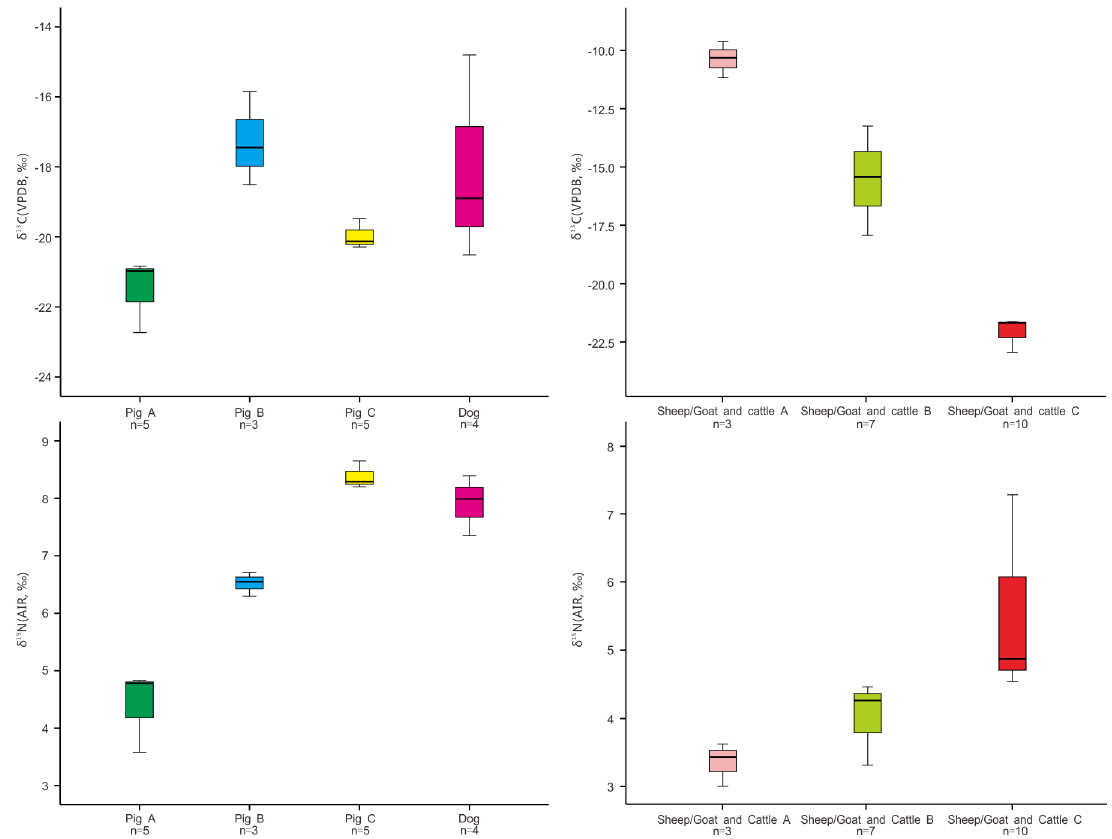
Fig 4. Isotopic value distributions for domesticated animals showing groups with different husbandry strategies.